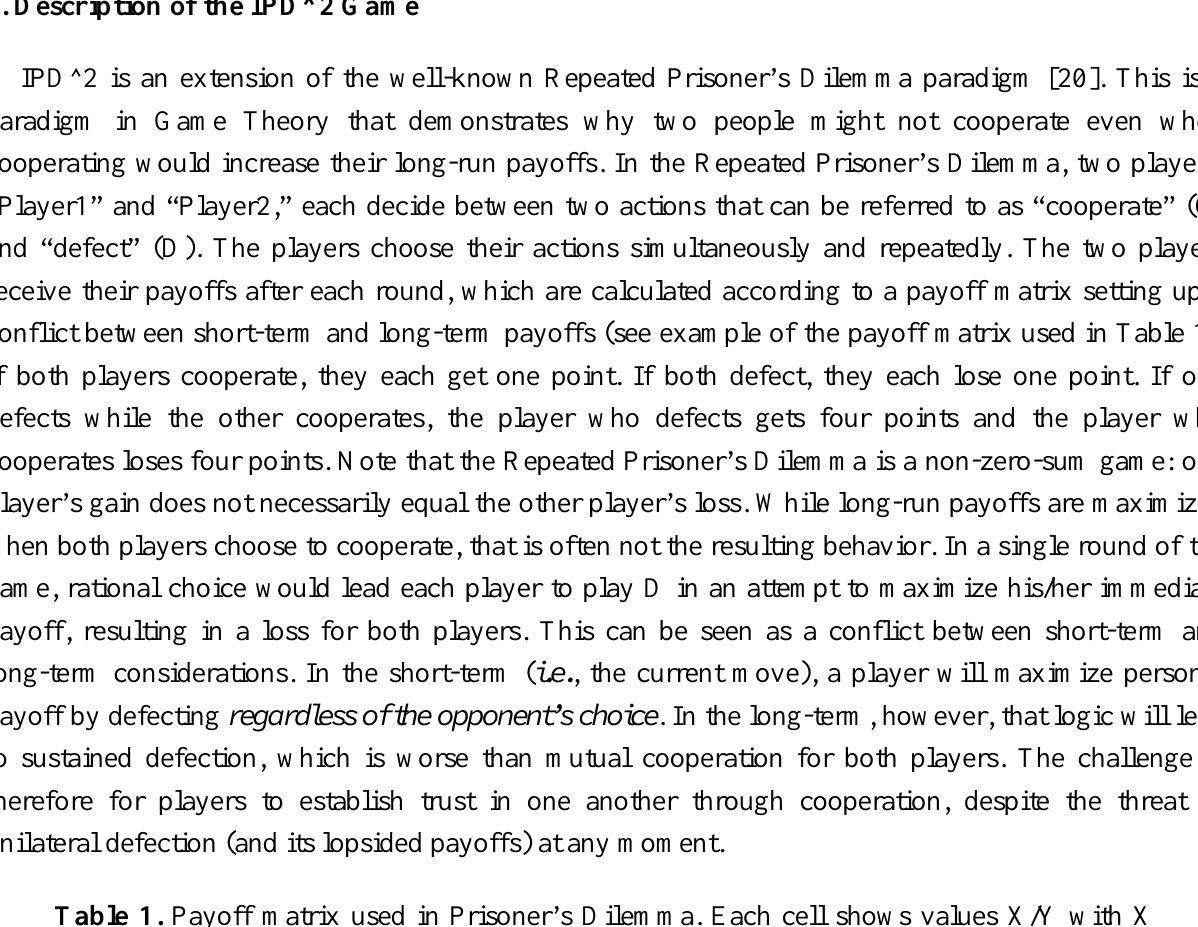
Table 1. Payoff matrix used in Prisoner’s Dilemma. Each cell shows values X/Y with X being the payoff to Player 1 and Y the payoff to Player 2 for the corresponding row